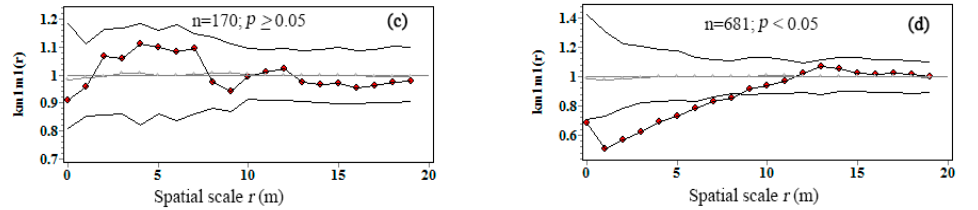
Figure 5. Univariate mark correlation function k mm (r) for intraspecific interaction on C accumulation in Pinshuo opencast coal mine, China. Straight gray line indicated the theoretical k mm (r) ; black line with red dots indicated the observed the k mm (r) ; polygonal black line without red dots indicated the 95% simulation envelops. ( a ) Planted R. pseudoacacia ; ( b ) seeded-in R. pseudoacacia ; ( c ) P. tabuliformis ; ( d ) U. pumila .